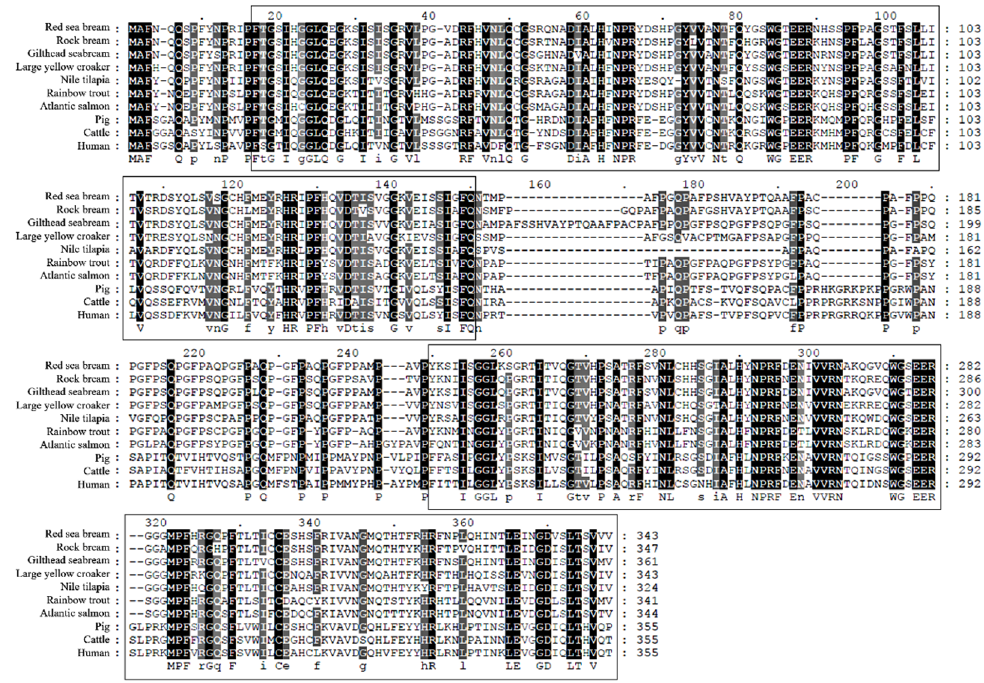
Figure 1. Multiple sequence alignment analysis of the deduced amino acid sequence of PmGal-9 with fish Gal-9 sequences. This analysis is based on the following sequence data: rock bream (ANN46244), gilthead sea bream (XP_030261557), large yellow croaker (XP_010754381), Nile tilapia (XP_003458375), rainbow trout (ACO08221), Atlantic salmon (ACI67584), pig (NP_999097), cattle (NP_001034266), and human (CAB93851). The predicted galactose-binding lectin domains are indicated by the box. Black boxes: identity = 100%; gray boxes: 80% ≤ identity < 100%; light gray boxes: 50% ≤ identity < 80%. Table 1. Similarities between deduced amino acid sequences of PmGal-9 and those of homologs in other species.